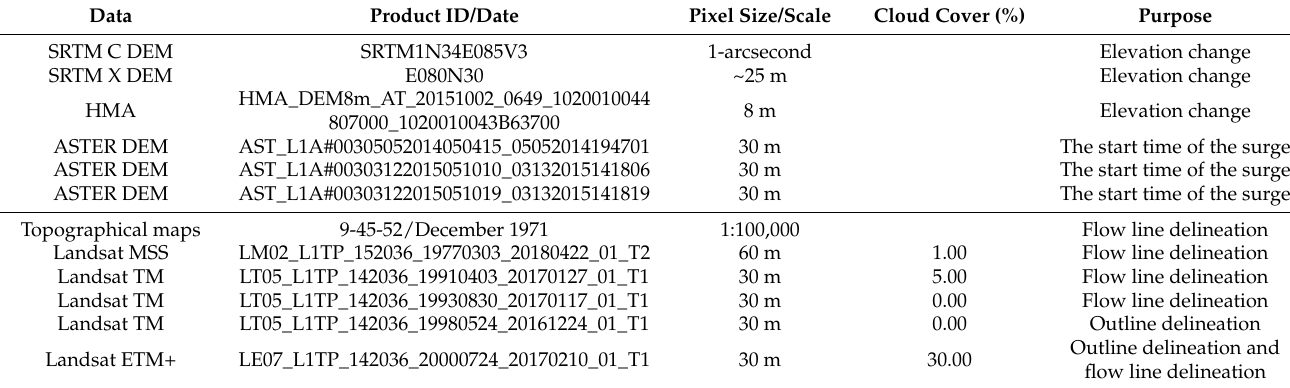
Table A2. Information on remote sensing